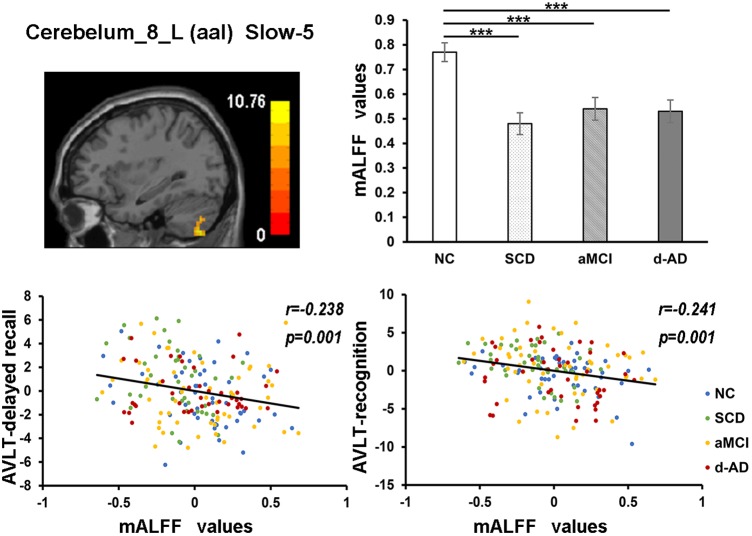
The correlation between mALFF values of the Cerebelum_8_L (aal) in slow-5 band and delayed recall/recognition of AVLT scores. The row 1, column 1 showed the corresponding anatomic location of Cerebelum_8_L (aal) in the brain. The row 1, column 2 described corresponding group comparison obtained by post hoc test (Bonferroni correction, P < 0.05). ∗∗∗ means significant level P < 0.001. The row 2 showed negative correlation between this region and delayed recall/recognition of AVLT scores (Bonferroni correction, P < 0.05/5). Corresponding correlation coefficient “r” and significant level “p” were marked. NC, normal controls; SCD, subjective cognitive decline; aMCI, amnestic mild cognitive impairment; d-AD, dementia of Alzheimer’s disease; AVLT, the auditory verbal learning test.